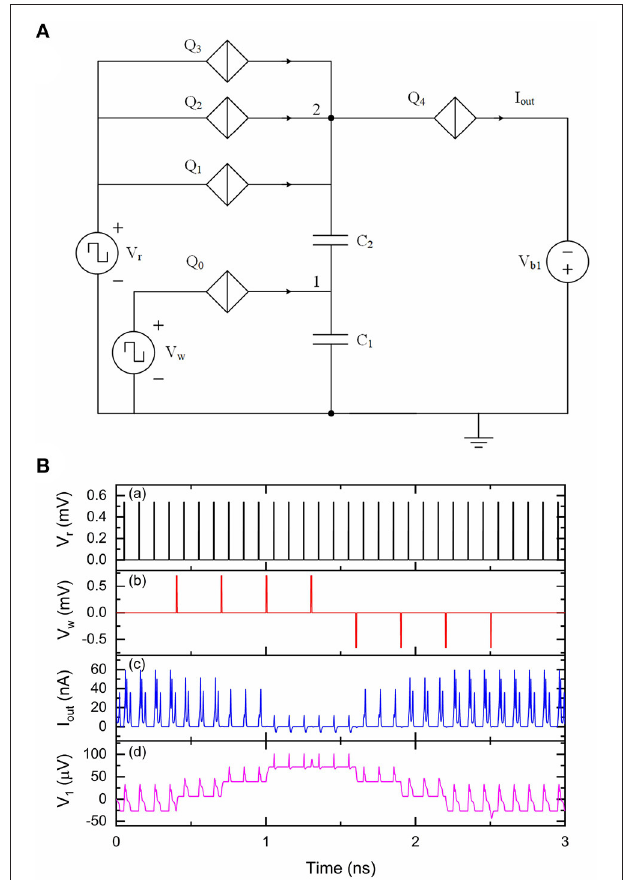
FIGURE 2 | A multi-weight QPSJ-based synaptic circuit that has two inputs V r and V w and one output I out . The weight can be modified by applying positive or negative pulses at V w , and can be read-out by applying positive pulses at V r . V r was 0.54 mV and V w was 0.7 mV. The V c values used for Q 0 – Q 4 were 0.3, 0.5, 0.52, 0.54, and 0.31 mV, respectively. C 1 was 9.2 fF and C 2 was 1.2 fF. V b1 was 0.5 mV. (A) Circuit schematic. (B) Simulation results of the synaptic circuit. (a) Read signal V r . (b) Write signal V w . (c) Output current I out . (d) Voltage at node